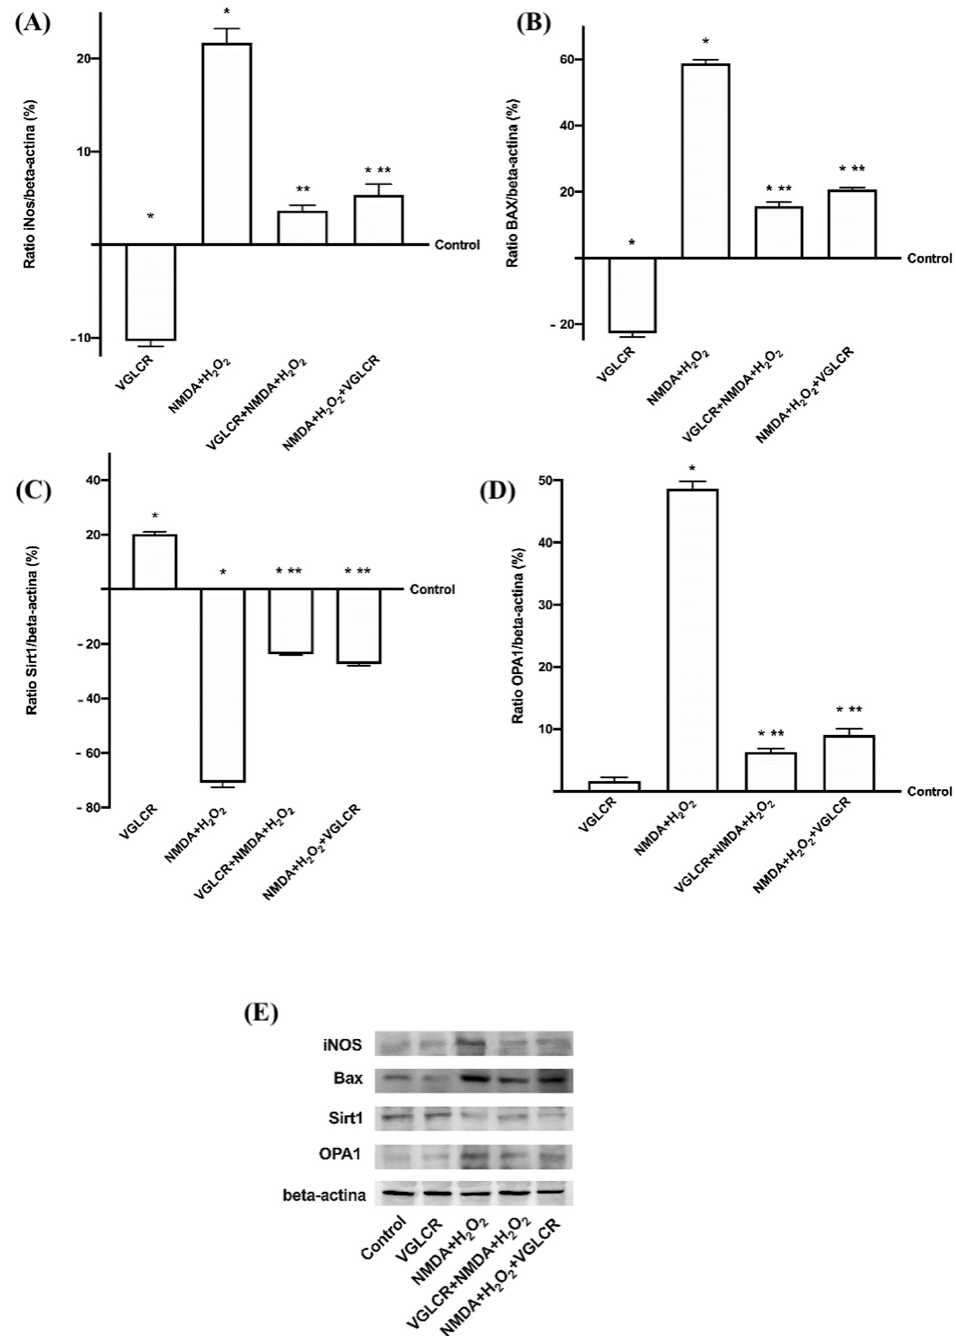
Figure 7. Western blot and densitometric analysis. In ( A ) iNOS, in ( B ) Bax, in ( C ) SIRT1, in ( D ) OPA1, and in ( E ) Western blot of iNOS, Bax, SIRT1, and OPA1. Retinal tissues were treated with NMDA and H 2 O 2 added together, and before and after VGLCR stimulations. The images shown are an example of each protein obtained from four independent experiments. The results of 4 independent experiments performed in duplicates are expressed as means ± SD (%) vs. control, normalized and verified on β -actin detection. * p < 0.05 vs. control; ** p < 0.05 vs. NMA + H 2 O 2 ; VGLCR + NMDA + H 2 O 2 p < 0.05 vs. NMDA + H 2 O 2 + VGLCR. The abbreviations are the same as used in Figure 1.